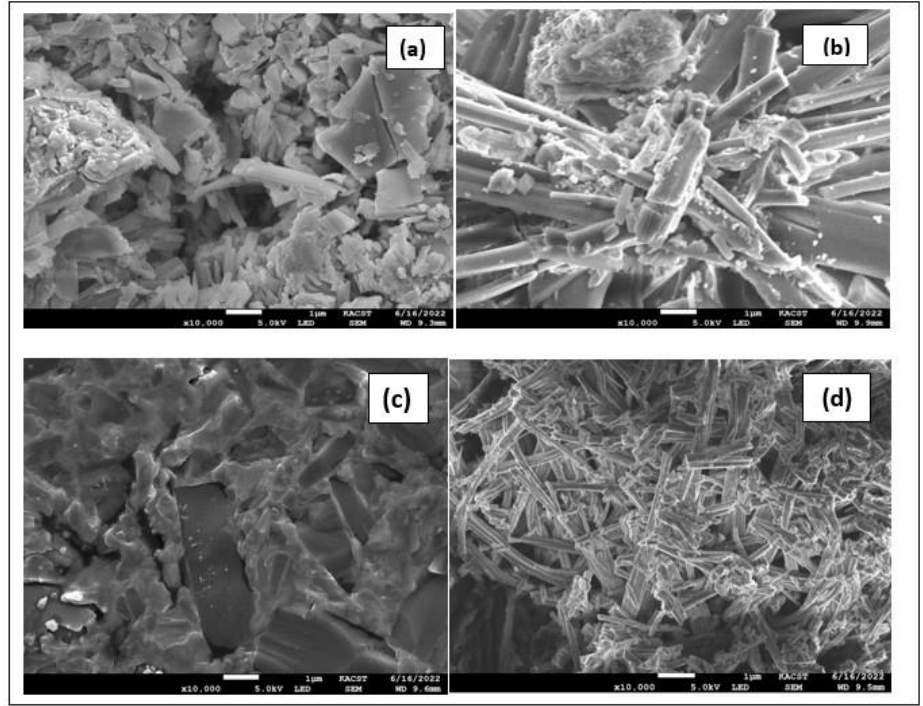
Figure 8. SEM micrographs of ( a ) Mn(II), ( b ) Co(II), ( c ) Cr(III), and ( d ) Pd(II)